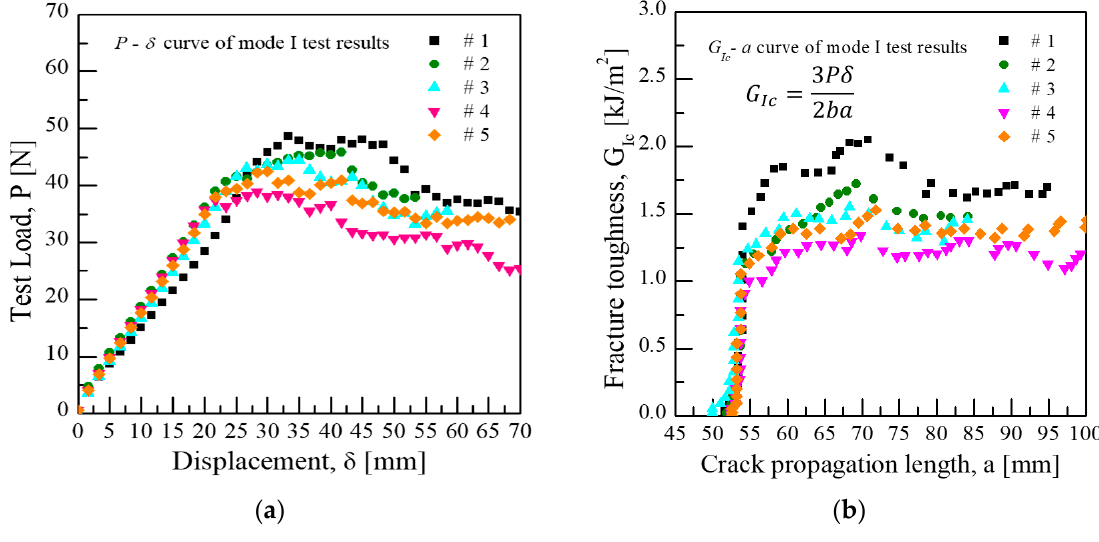
Figure 7. Fracture toughness test results of Mode I: ( a ) 𝑃 − 𝛿 curve and ( b ) 𝐺 − 𝑎 curve.